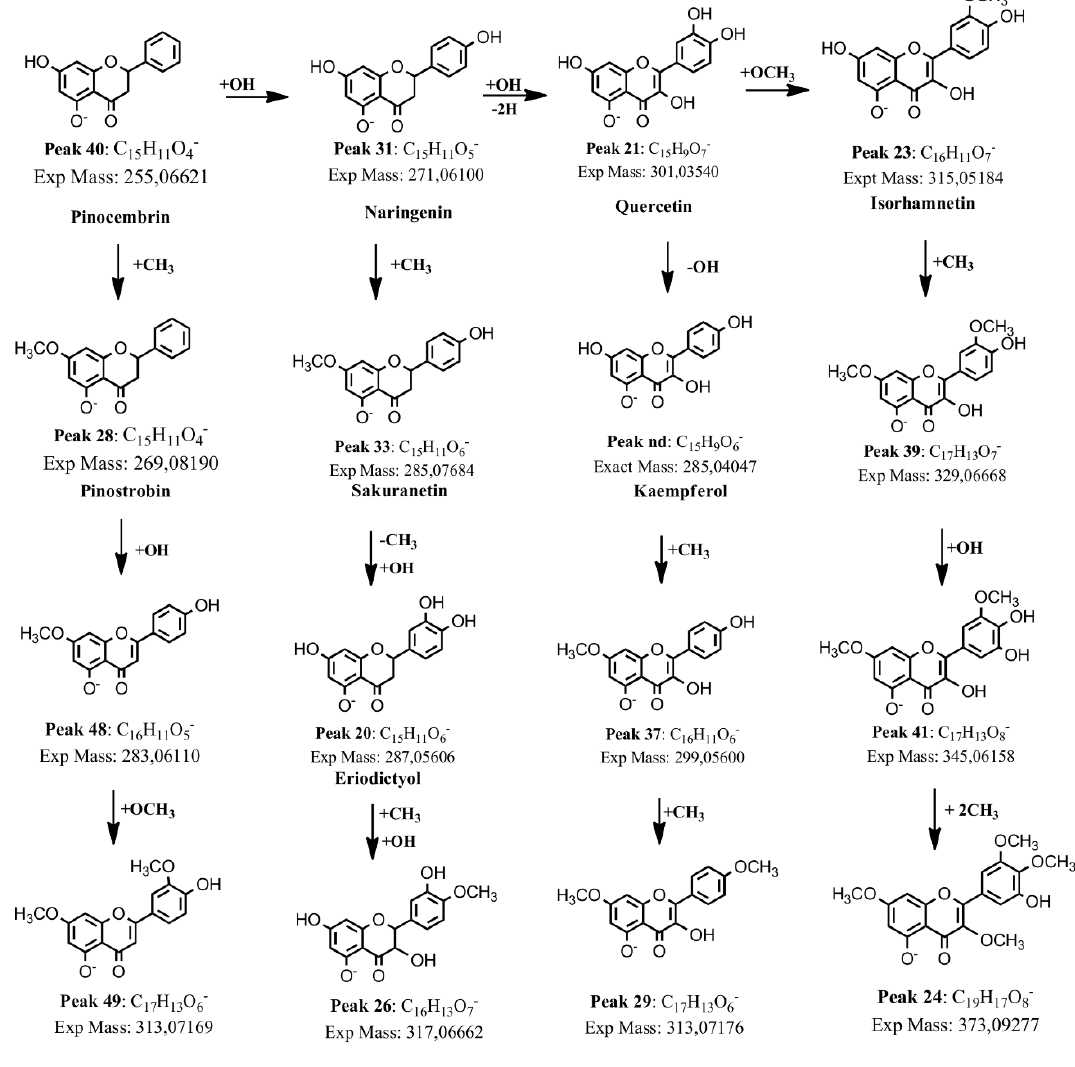
Figure 4. Proposed biosynthetic pathway between flavonoid derivatives detected in H. taltalense. nd: Compound not detected.